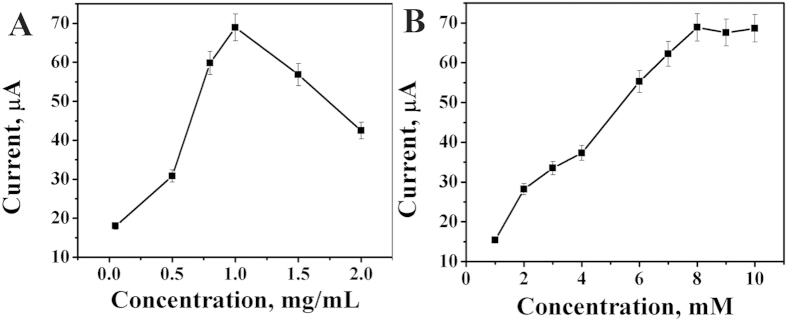
The optimization of experimental conditions with Au/PDA/Fe3O4@C@PGC concentration (A) and K4[Fe(CN)6] concentration (B).